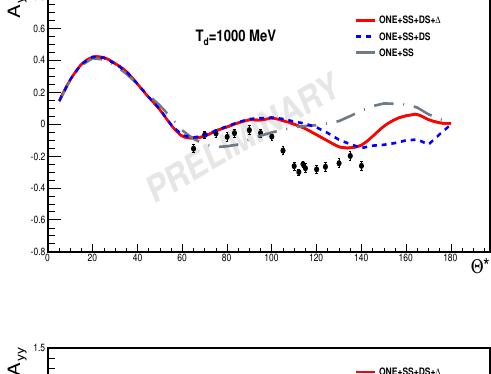
Figure 10. The angular dependence of the tensor analyzing power A yy at the deuteron kinetic energy T d of 1000 MeV. Lines and symbols are the same as in Fig. 6